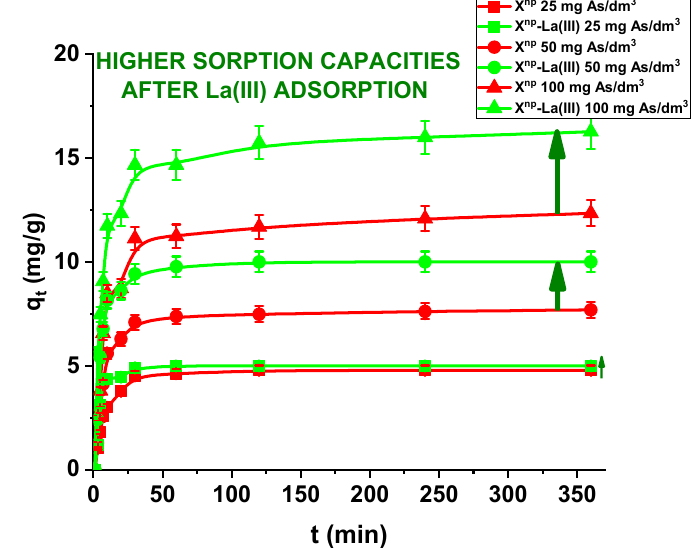
Figure 11. Sorption of arsenic(V) on X np and X np -La(III) as a function of time (c 0 = 25, 50 and 100 mg/dm 3 , pH = 6, shaking speed 180 rpm, temperature 295 K).